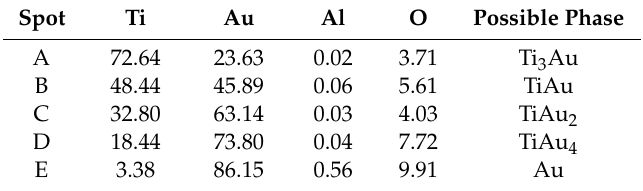
Table 1. Energy dispersive spectroscopy (EDS) results of the spots marked in Figure 3 (at. %). Spot Ti Au Al O Possible Phase A 72.64 23.63